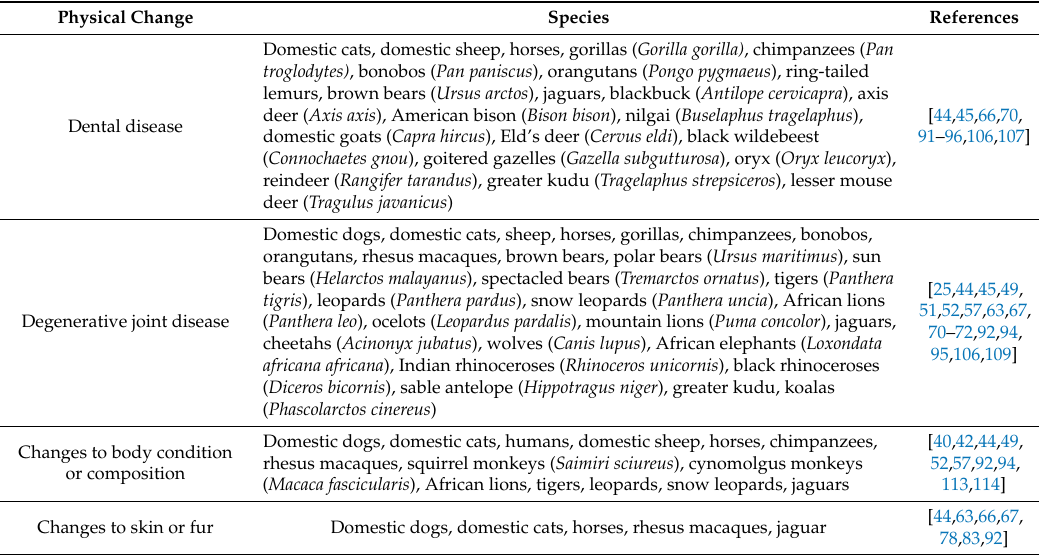
Table 1. Common physical changes described in ageing animals of different